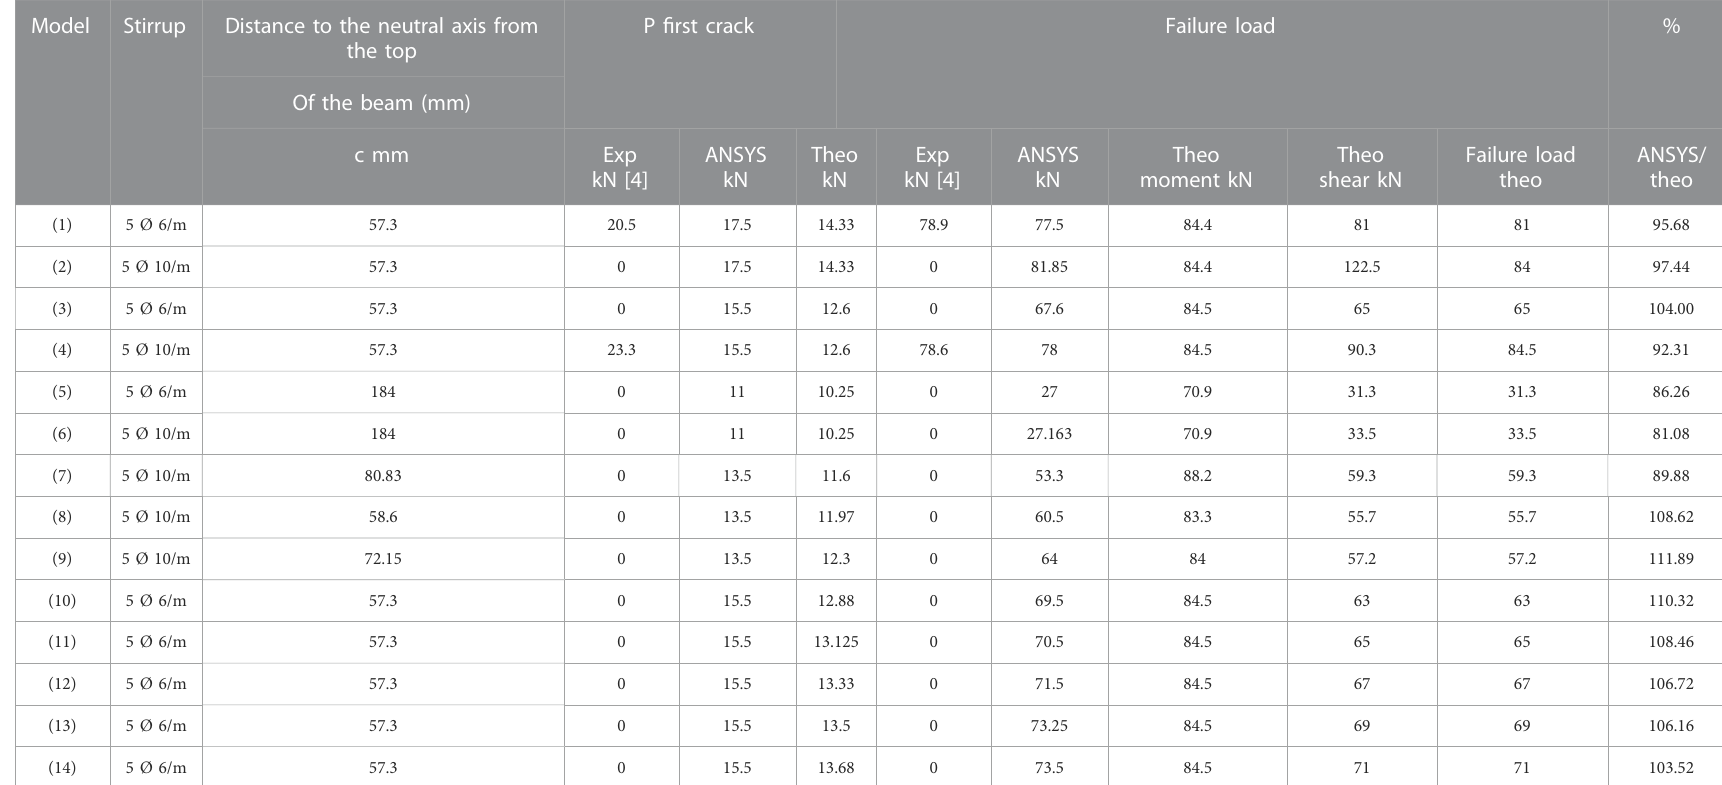
TABLE 3 Comparison between the experimental [4], fi nite elements, and computational analysis at the fi rst crack and failure load. Model Stirrup Distance to the neutral axis from the